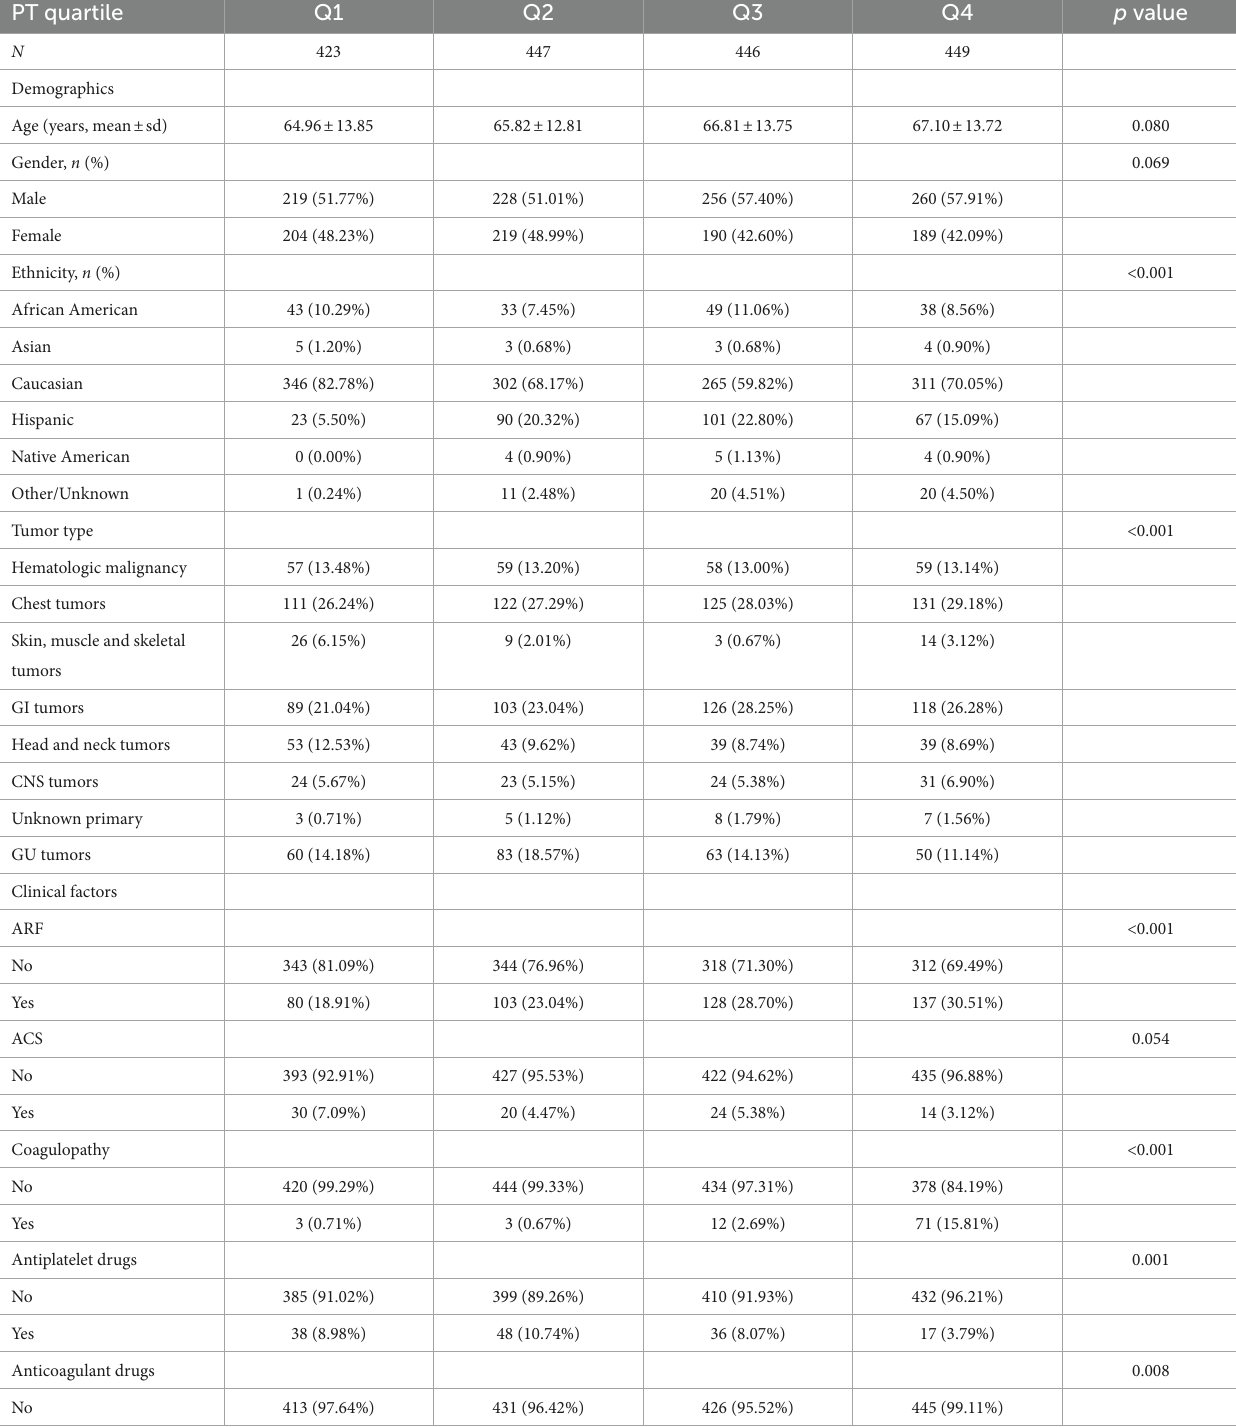
TABLE 2 Characteristics and outcomes of